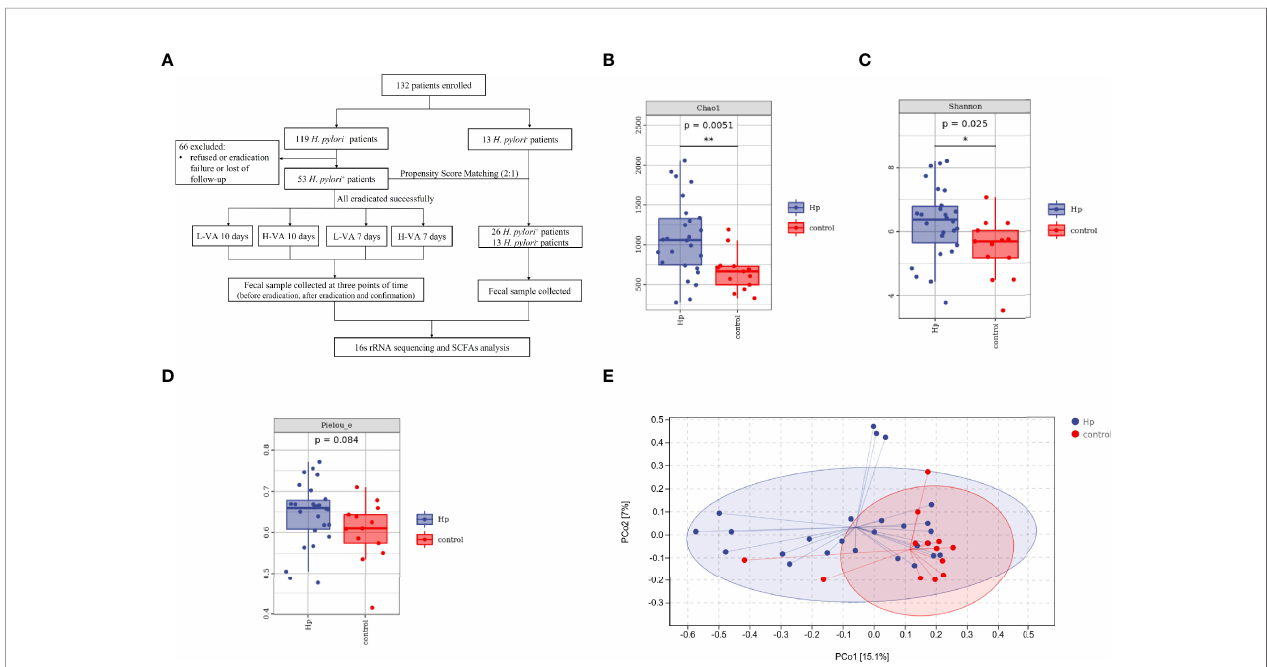
FIGURE 1 | The fl owchart of this study and diversity of the gut microbiota between H. pylori -positive patients and normal controls. (A) Overview of the study design. Bacterial alpha diversity estimated by Chao1 (B) , Shannon (C) , and Pielou indices (D) between H. pylori -positive patients and normal controls. (E) Bacterial beta diversity estimated by PCoA between H. pylori -positive patients and normal controls. L-VA: dual therapy consisting of a low dose of amoxicillin (1000 mg b.i.d.) and VPZ (20 mg b.i.d.); H-VA: dual therapy consisting of a high dose of amoxicillin (1000 mg t.i.d.) and VPZ (20 mg b.i.d.); SCFAs, short-chain fatty acids; Hp, H. pylori - positive; Control, H. pylori -negative; PCoA, principal coordinate analysis. * P < 0.05, ** P <